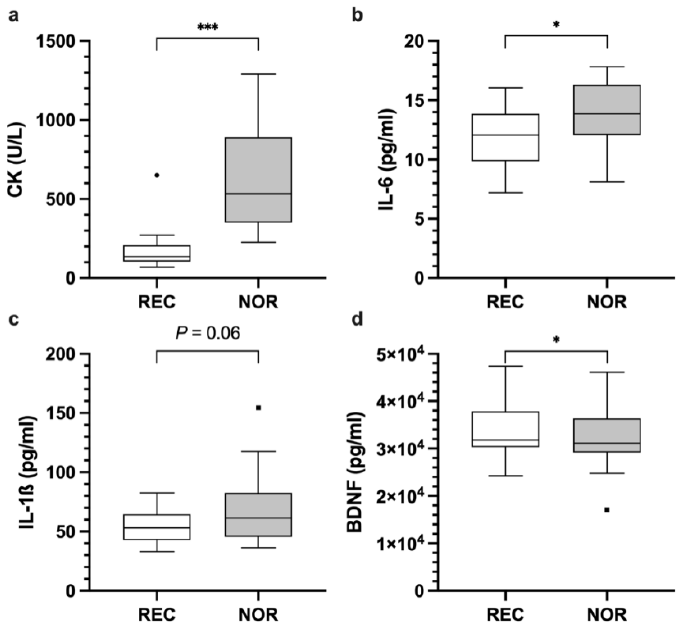
Figure 3. Enzyme activity of CK ( a ), concentration of IL-6 ( b ), IL-1ß ( c ), and BDNF ( d ) in soccer players at REC and NOR time points. (*) indicates P < 0.05 and (***) indicates P < 0.001. Raw data are shown.